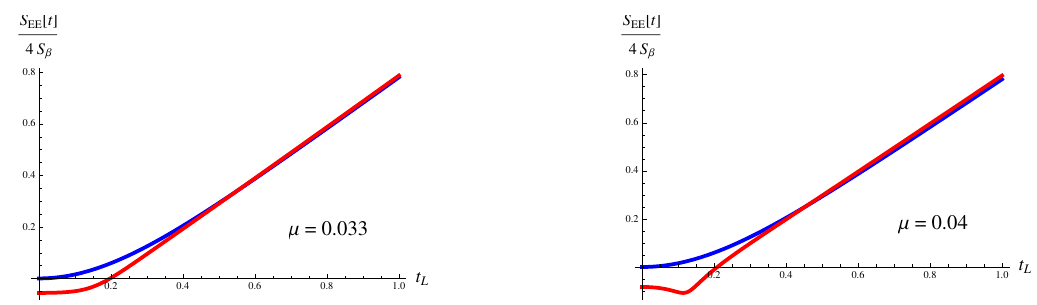
Figure 5 . The entanglement entropy of L [ R as a function of time. The blue curve is for (cid:22) = 0 and the red curve is for (cid:22) 6 =